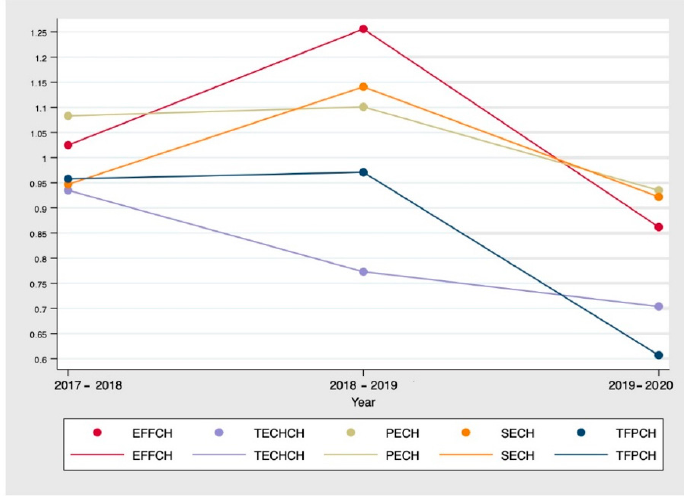
Figure 2. Malmquist index and its decomposition index in 2017–2020.